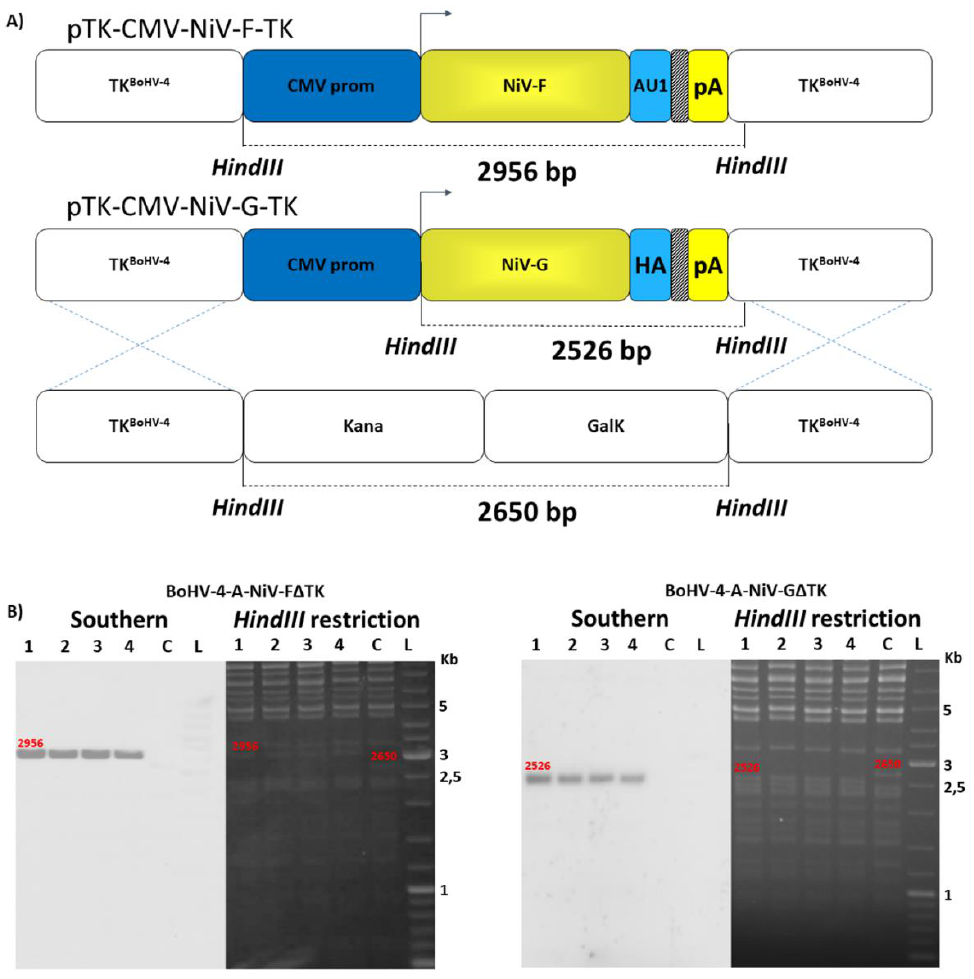
Figure 1. Generation of recombinant BoHV-4 vectors. Diagram (not to scale; ( A ) showing the retargeting event obtained by heat-inducible homologous recombination in SW102 containing pBAC-BoHV-4-A-TK-KanaGalK-TK, where the Kana/GalK cassette was replaced with the CMV-NiV-F, and CMV-NiV-G expression cassettes flanked by BoHV-4 TK sequences, located in pINT2 shuttle plasmid vector. ( B ) Representative 2-deoxy-galactose resistant colonies (1, 2, 3 and 4) tested by HindIII restriction enzyme analysis, agar gel electrophoresis, and Southern blotting performed with specific probes for the NiV-F, and NiV-G ORFs. The 2650 bp band, corresponding to the un-retargeted pBAC-BoHV-4-A-TK-KanaGalK-TK control (C), has been replaced by a 2956 bp band in pBAC-BoHV-4-A-CMV-NiV- FΔTK and by a 2526 bp band in pBAC -BoHV-4-A-CMV-NiV- GΔTK.